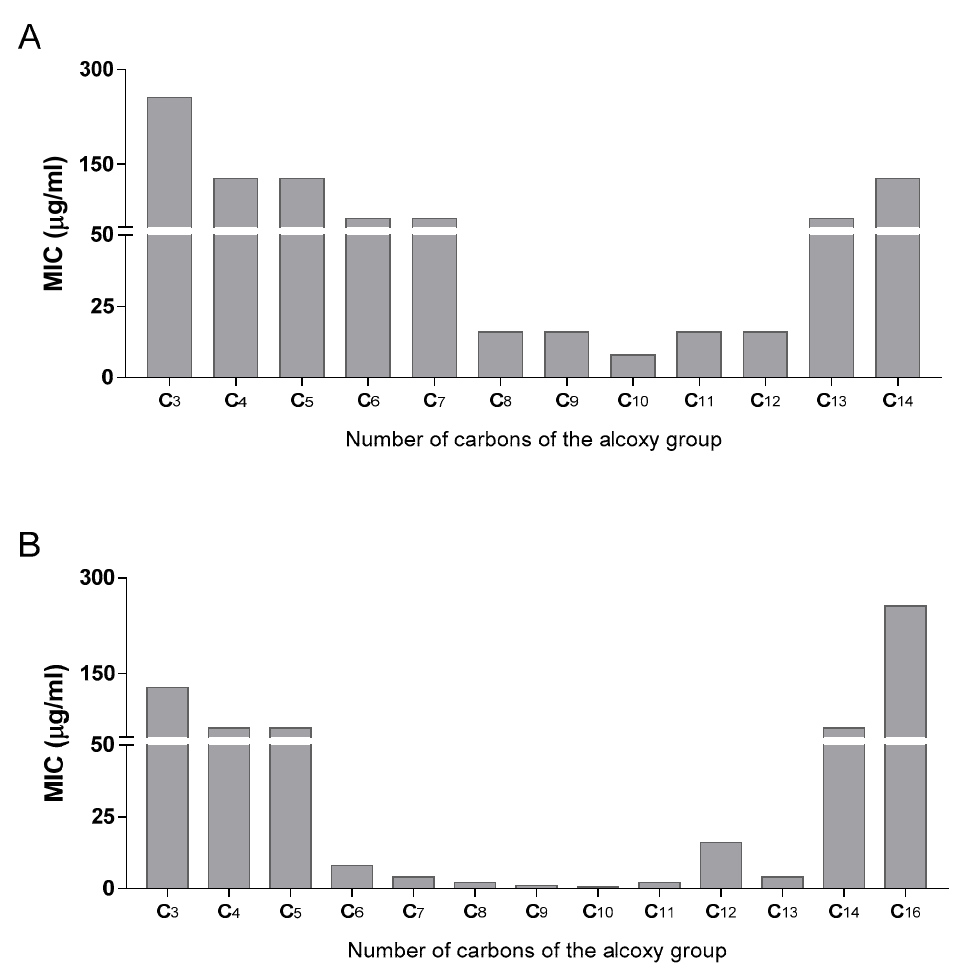
Figure 2. (MIC of 2 series of esters against M. tuberculosis in function of the chain length of the alkoxy group ( A ) 4-NO 2 series, ( B ): 3,5-NO 2 series). The numbers in the X -axis represent the carbon length of the alkyl chain. All alkyl chains are linear and saturated.